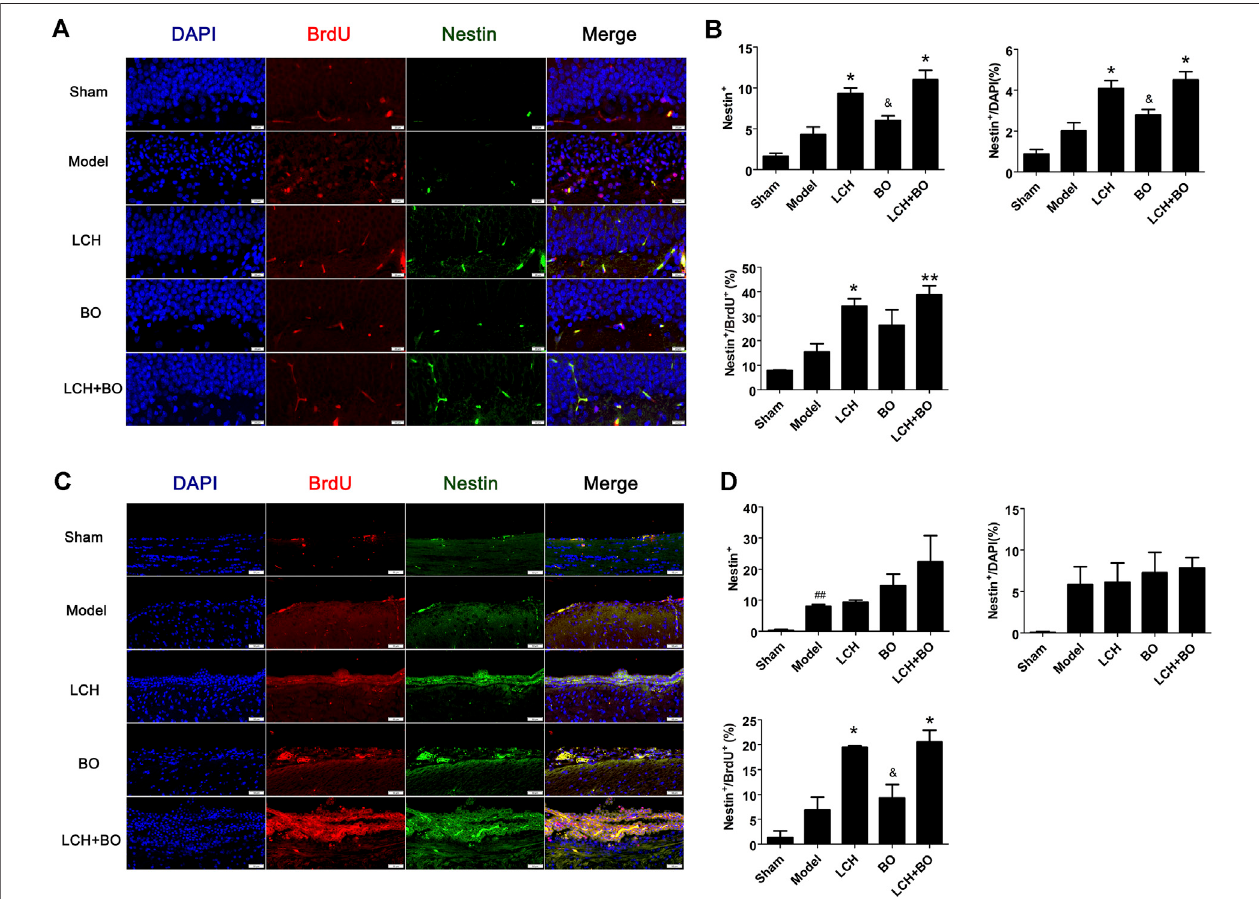
FIGURE 3 | NSC proliferation within DG and SVZ of MCAO rats. (A) Representative double-immunostaining images of Nestin + /BrdU + in the DG area. (B) The resultsofNestin + cells,Nestin + /DAPI,andNestin + /BrdU + intheDGarea( n (cid:1) 3). (C) Representativedouble-immunostainingimagesofNestin + /BrdU + intheSVZarea. (D) The results of Nestin + cells, Nestin + /DAPI, and Nestin + /BrdU + in the SVZ area ( n (cid:1) 3). ## p < 0.01 compared to the sham group; * p < 0.05, ** p < 0.01 compared to the model group; & p < 0.05 compared to the LCH + BO group.